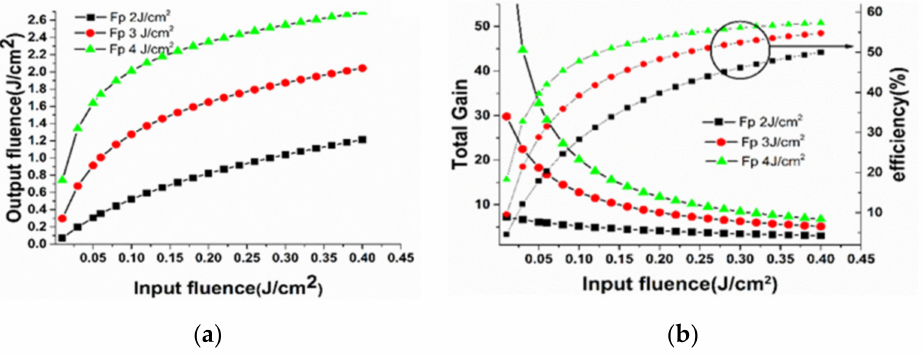
Figure 11. Evolution of the output seed fluence ( a ); gain and energy extraction efficiency ( b ) on the input seed fluence at different pump fluence